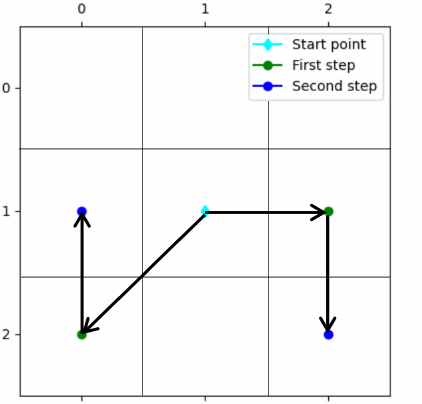
Figure 5. Examples of redundant triangular